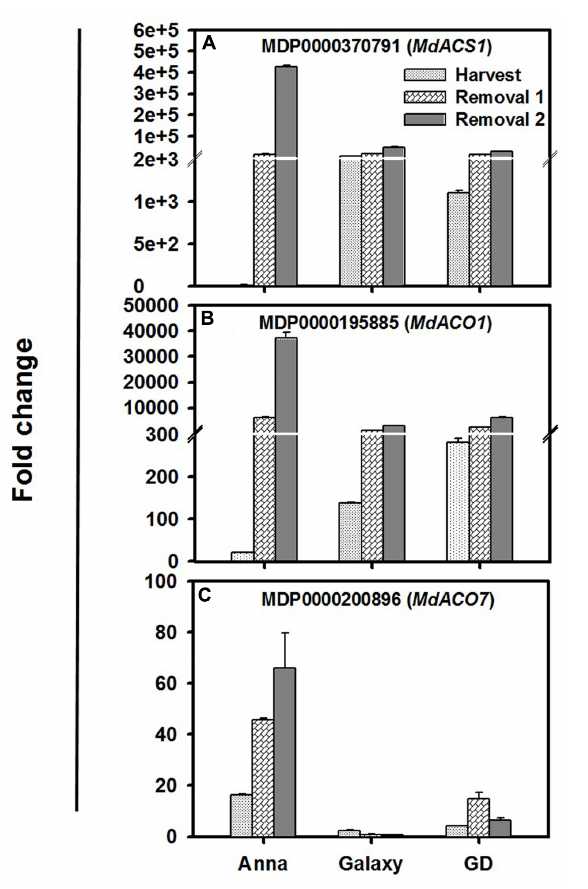
FIGURE 3 | Expression profiles of (A) MdACS1 , (B) MdACO1 , and (C) MdACO7 genes at harvest and storage (R1–R2). Expression of genes was calculated by 2 − (cid:49)(cid:49) C t method, considering to the expression obtained at S1 stage and to house-keeping gene (HKG, actin), and is presented as relative fold change. Each value is the mean of three technical replicates ± SE. This is a representative of two independent